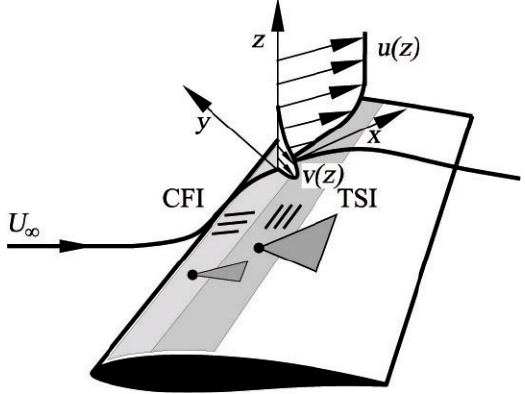
Figure 26. Transition mechanisms on a swept wing. Herbert.Oertel/CC BY-SA.